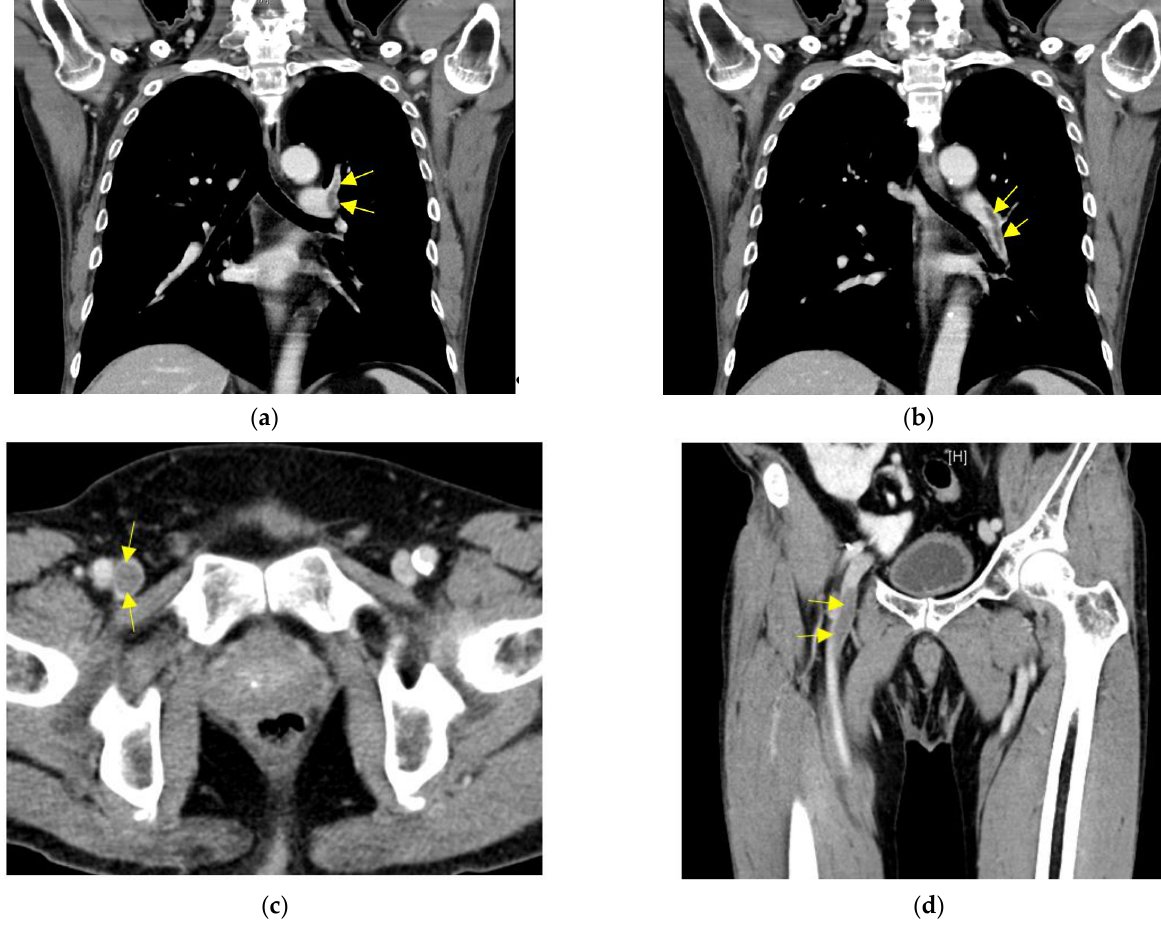
Figure 1. CT of chest and extremity: ( a , b ) left pulmonary artery thrombosis; ( c , d ) right femoral vein thrombosis. Arrow indicates thrombosis.